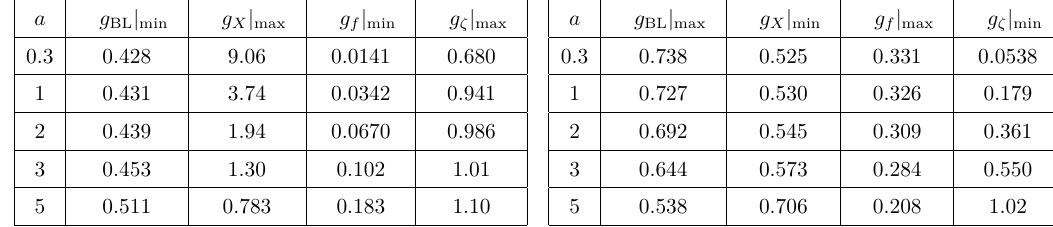
Table 2 . The minimum and maximum values of g BL , g X , g f and g ζ for various values of a .